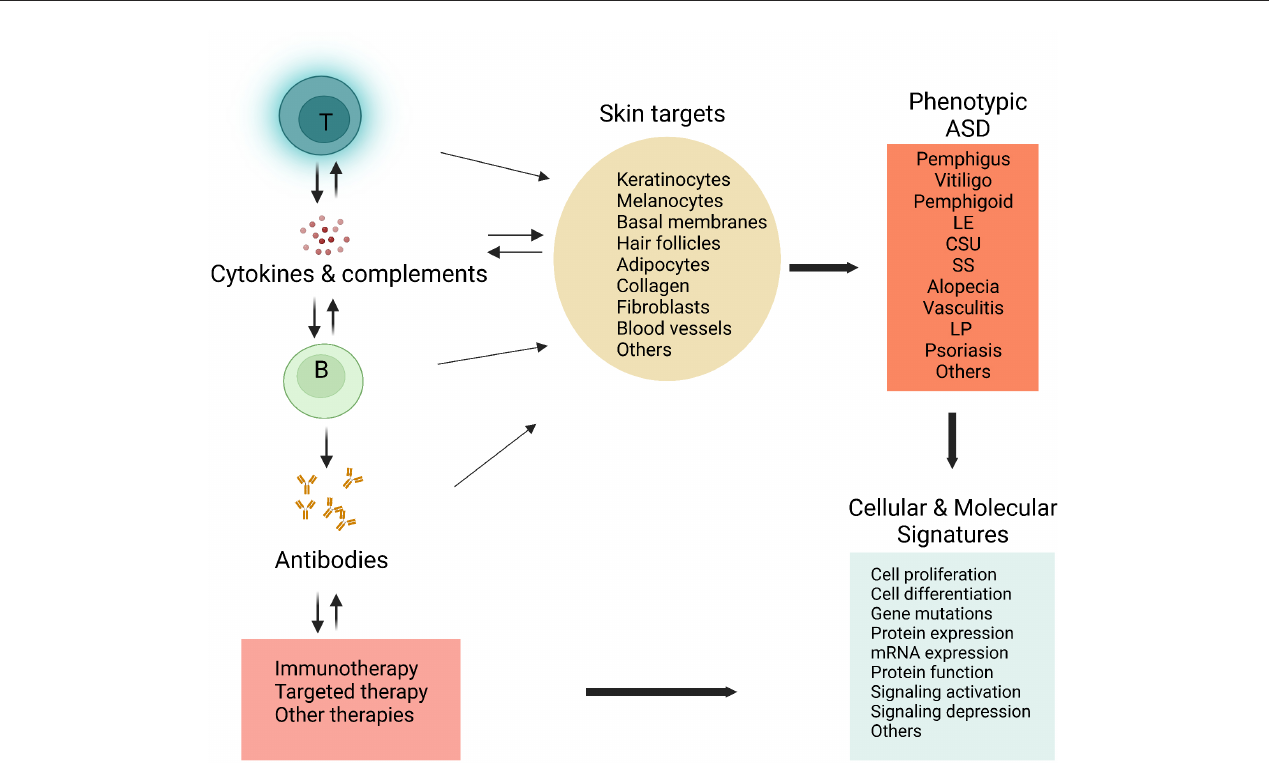
FIGURE1 Schematic strategies in researching autoimmune or inflammatory skin diseases. Cellular or tissue components in the skin can be targeted by the immune effectors, including T lymphocytes (T), B lymphocytes (B), autoantibodies, and various cytokines. A broad range of cells or tissues are involved, leading to diverse skin diseases or ASD phenotypes. By the cellular and molecular approaches, such as microarray analysis, flow cytometry, immunofluorescence or immunohistochemistry, proteomics, metabolomics, and single-cell RNA sequencing, combined with state-of-art data analysis (bioinformatic analysis), characteristic cellular and molecular features or signatures could be identified in specific skin conditions. These findings may result in novel and more effective immunotherapies or targeted therapies for patients with ASD. ASD, autoimmune skin diseases; LE, Lupus erythematosus; LP, lichen planus; SS, systemic sclerosis; CSU, chronic spontaneous urticaria. The figure was created from Biorender